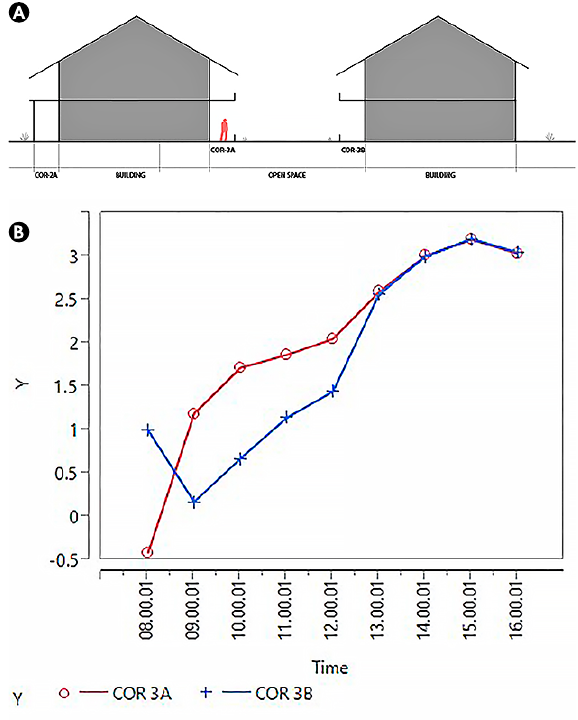
Figure 15. Section of CAN-A and CAN-B (b) Comparison of PMV at 2 points location in the CAN